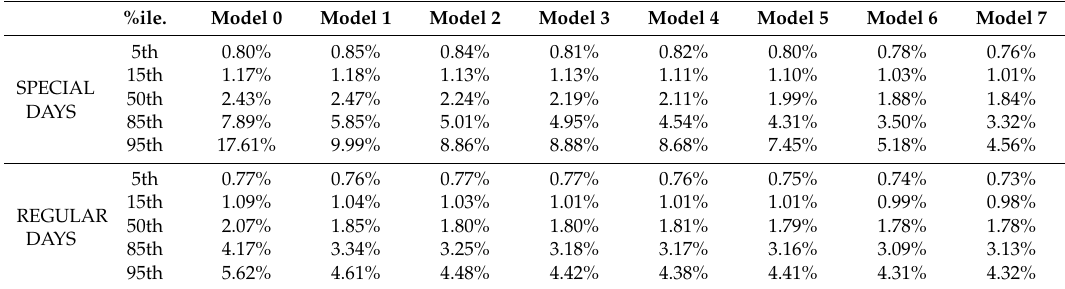
Table 12. Differences between special days type 1 and